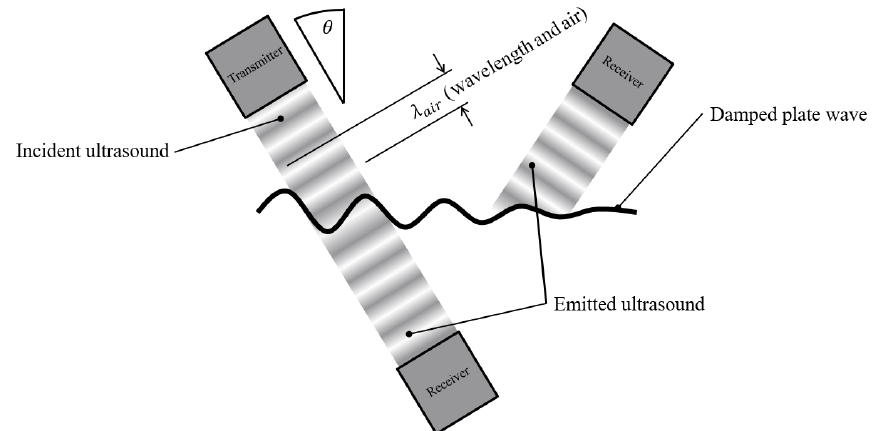
Figure 1. Excitation of Lamb waves with air-coupled ultrasound. The Lamb wave is excited by the transmitter and propagates from the left to right with a velocity of c Lamb .